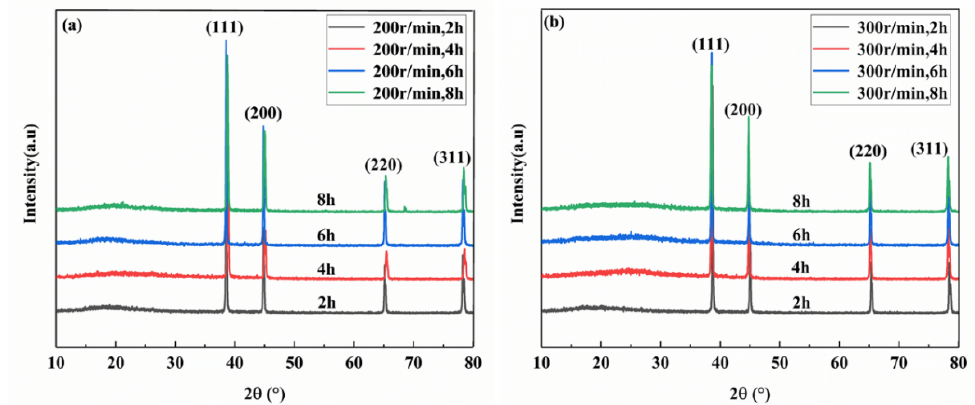
Figure 12. XRD diagram of vacuum hot-pressed composites. ( a ) 200 r/min; ( b ) 300 r/min.